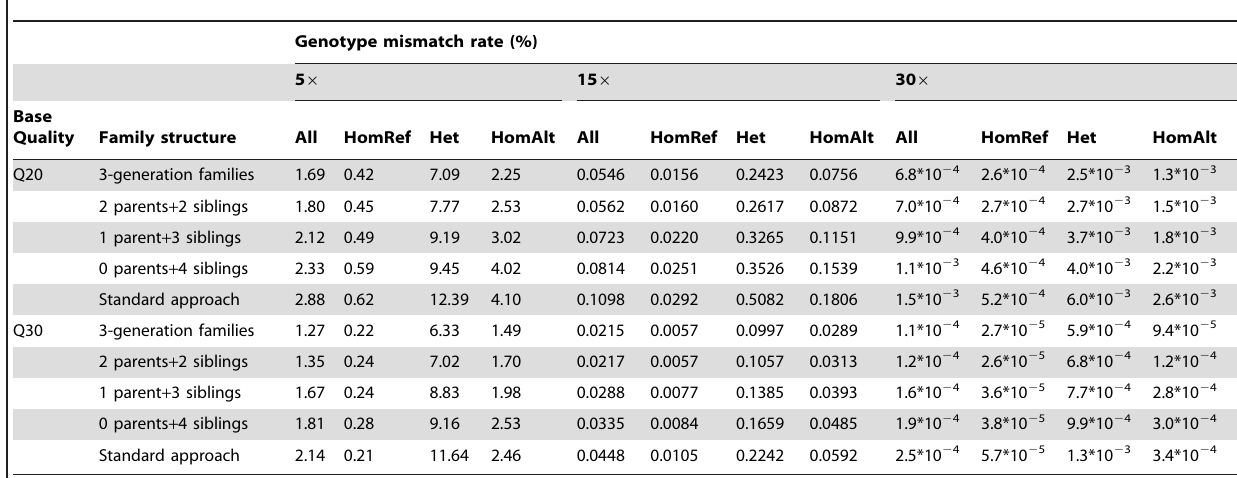
The mismatch rates are shown for 4 genotype categories: all genotypes (All), homozygous reference allele (HomRef), heterozygotes (Het), and homozygous alternative allele (HomAlt). doi:10.1371/journal.pgen.1002944.t002 PLOS Genetics |